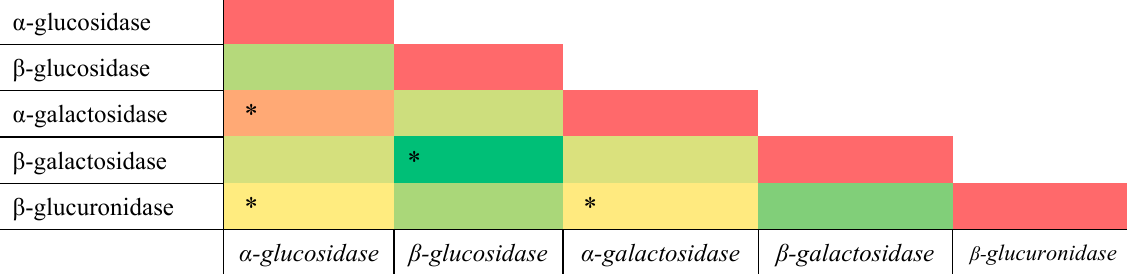
Figure 7. Pearson’s heatmap representing correlation between the activity of fecal enzymes. Green represents negative correlation, whereas orange and red represent positive correlation. *: ( p < 0.05).